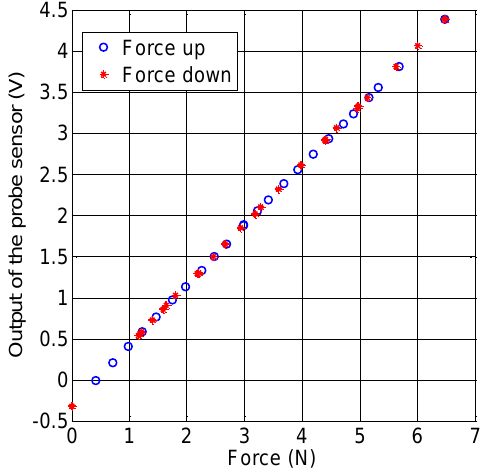
Figure 3. Data obtained when the probe presses against a polyurethane cone placed on the